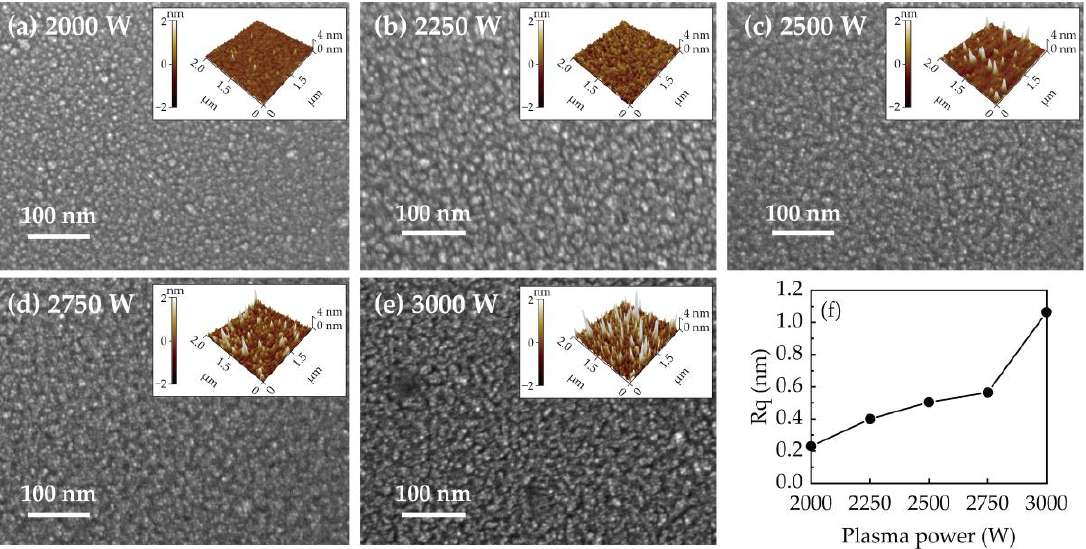
Figure 7. The FESEM image with a corresponding AFM image obtained at ( a ) 2000, ( b ) 2250, ( c ) 2500, ( d ) 2750, and ( e ) 3000 W. ( f ) The plot of RMS with the plasma powers.